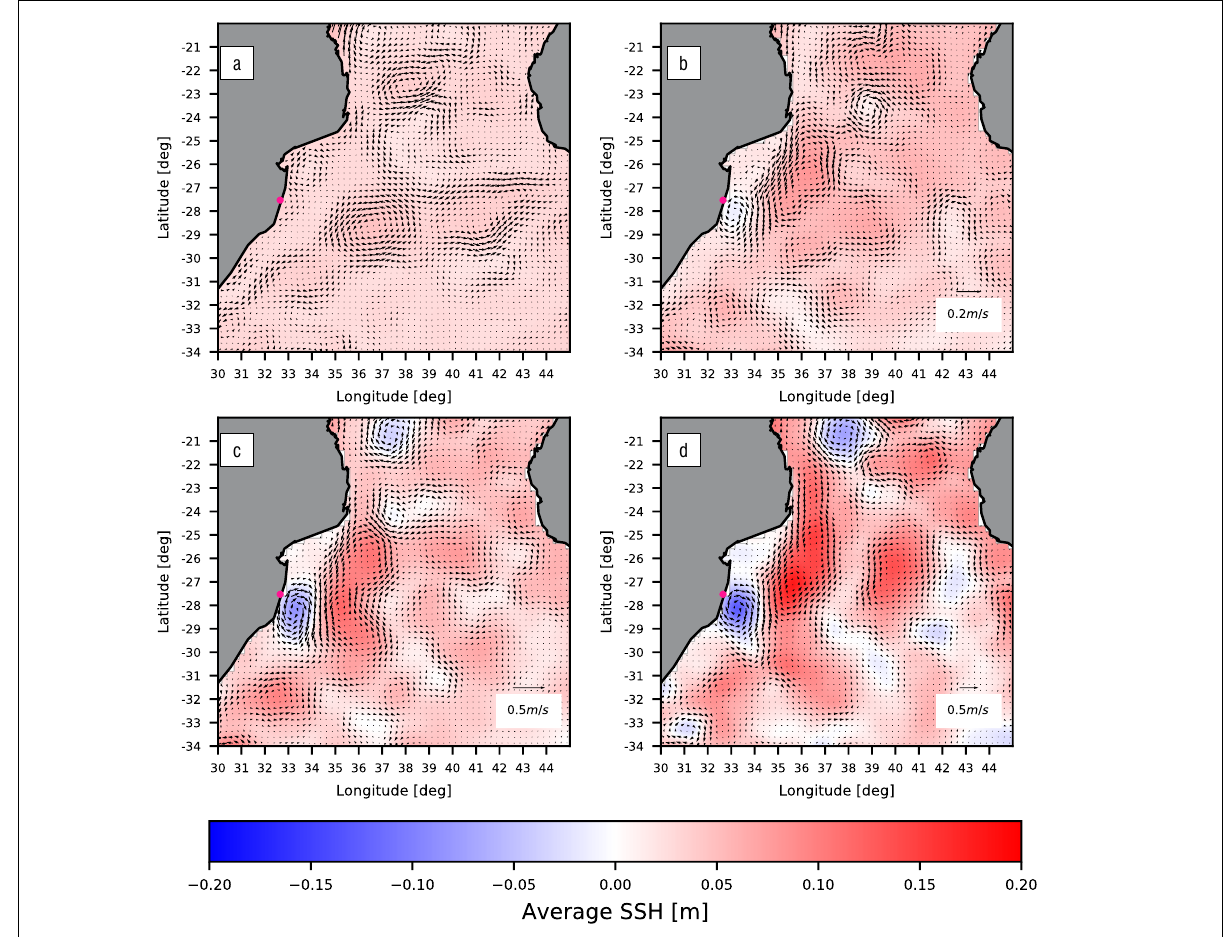
Figure 6: (a) Unconditionally averaged sea surface height (SSH) field. (b) Conditionally averaged SSH field at the peak of the temperature anomalies using a -1 °C threshold. (c) Conditionally averaged SSH field at the peak of the temperature anomalies using a -2 °C threshold. (d) Conditionally averaged SSH field at the peak of the temperature anomalies using a -3 °C threshold. Geostrophic currents have been overlaid as a quiver plot and are scaled by